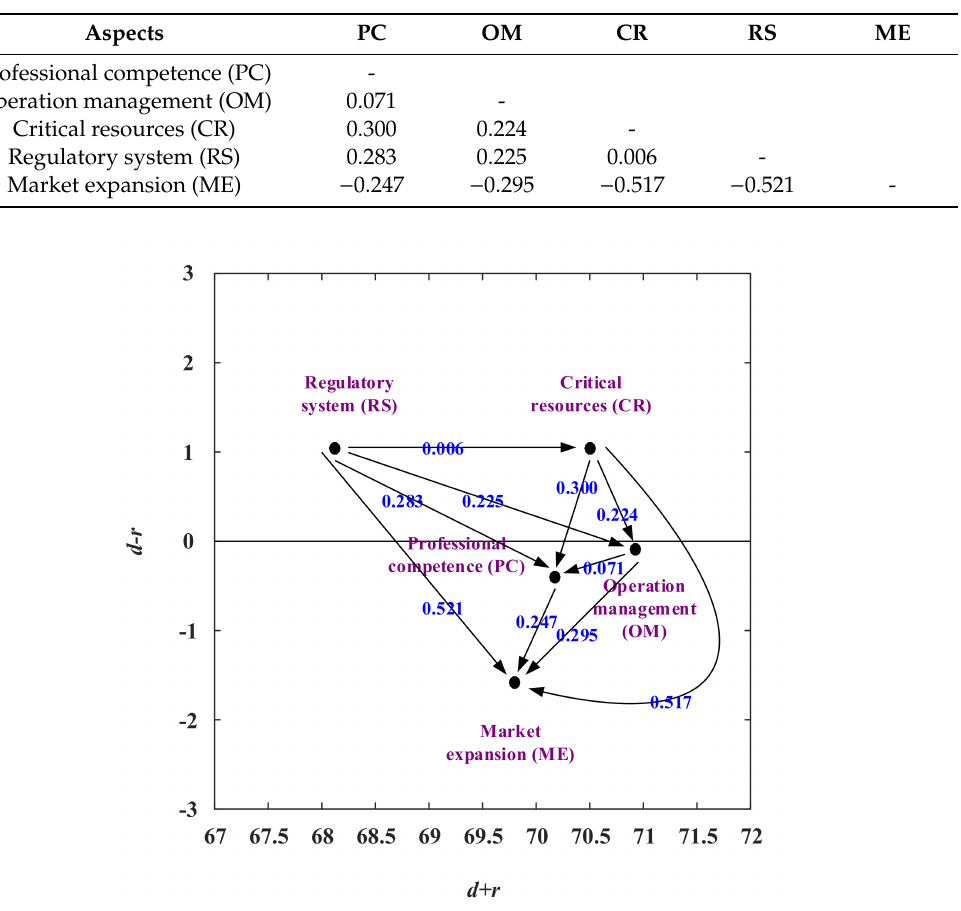
Figure 4. The network relation map (NRM) of digital transformation for Med-Tech